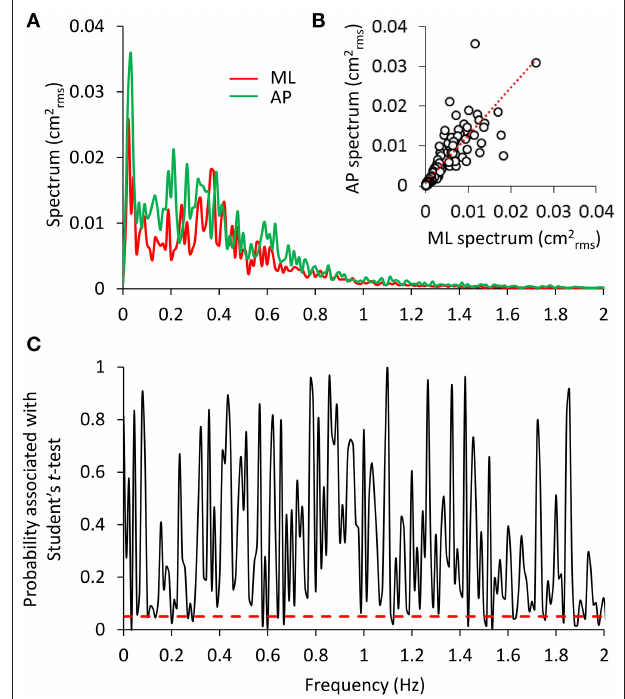
FIGURE 5 | Comparison between the ML and AP spectra. In (A) , the superimposed power spectra in the ML and AP directions (EC) appear similar, except for a slightly higher amplitude of the AP (green) compared to the ML spectrum (red). The regression line fitted to the data points of AP vs. ML (B) has a slope slightly higher than 1 and the intercept close to origin of the axes (y 1.15 0.0008, R 2 0.72, p < 0.001). The plot in (C) shows the = × + = probability values associated with the t -test of the point-to-point differences between the two spectra. The red dashed line indicates the significance of the differences at p < 0.05. Consistent but limited differences between the two spectra were observed at low